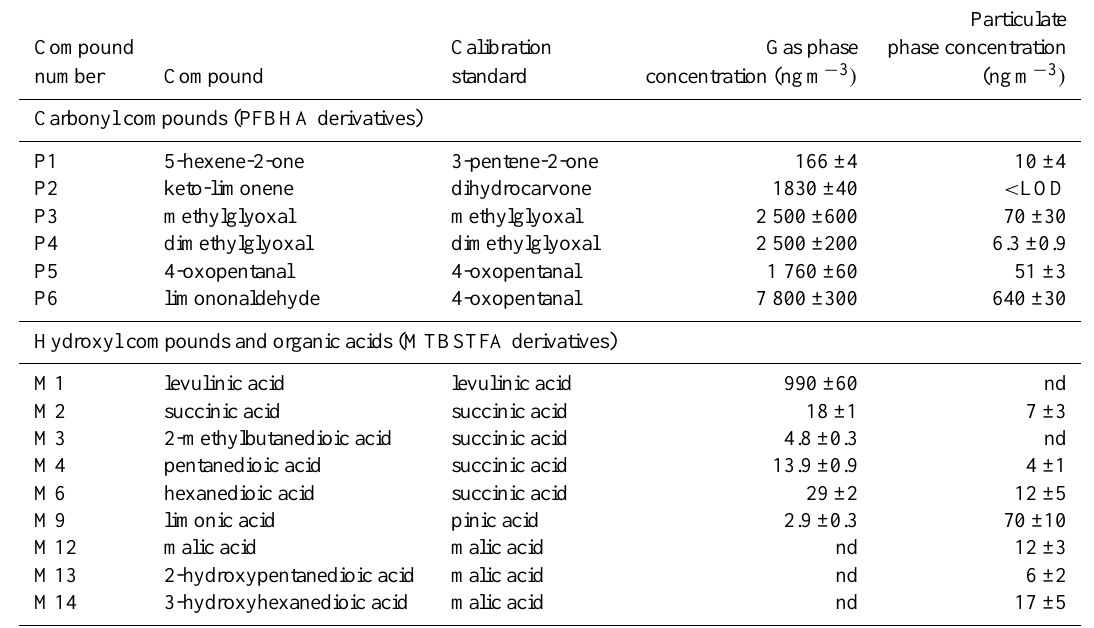
Table 8. Quantification of observed carbonyl compounds, organic acids and hydroxyl compounds. LOD: limit of detection. 1 nd: not detected.